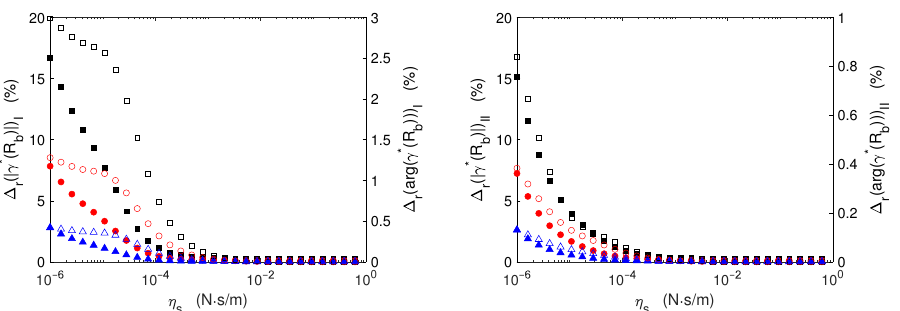
Figure 9. Relative differences in the modulus, ∆ r ( | γ ∗ ( R b ) | ) (solid symbols), and the argument, ∗ ( R ∆ ))) (open symbols), of the interfacial strain at the bicone rim between the solutions r ( arg ( γ b obtained with different mesh sizes taking as a reference the 2520 × 1260 mesh solution. Black symbols: 200 × 100 mesh. Red symbols: 440 × 220 mesh. Blue symbols: 1000 × 500. Left panel: PV-I; right panel: